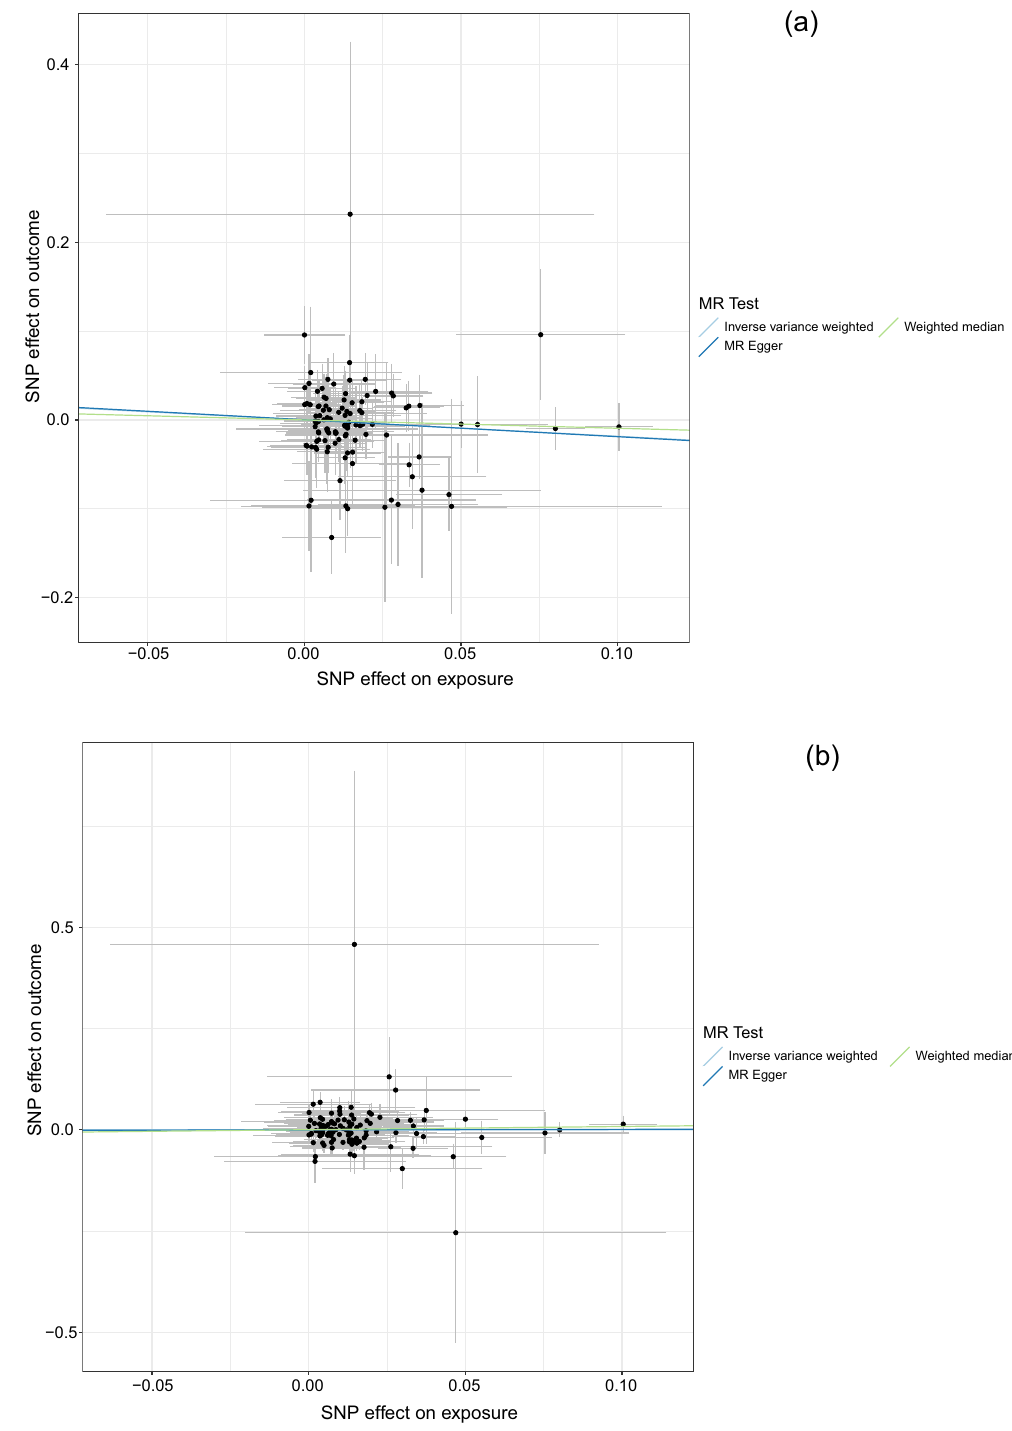
Figure 1. Analyses of vitamin D and total cancer risk ( a ) and colorectal cancer risk ( b ) with 110